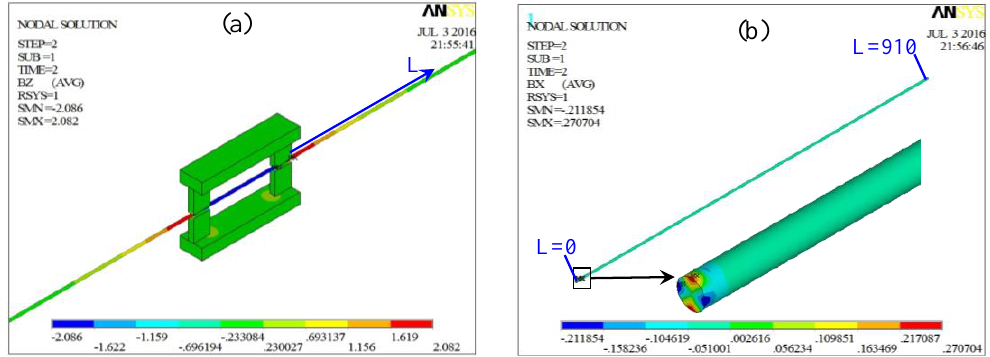
Figure 4. The calculated axial magnetic flux density ( a ) and the radial magnetic flux density ( b ).